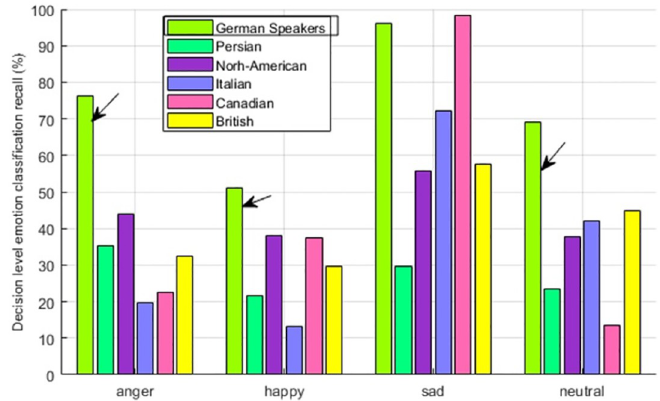
Fig 8. German Speaker—Multicultural Emotion Recall Comparison and In-group